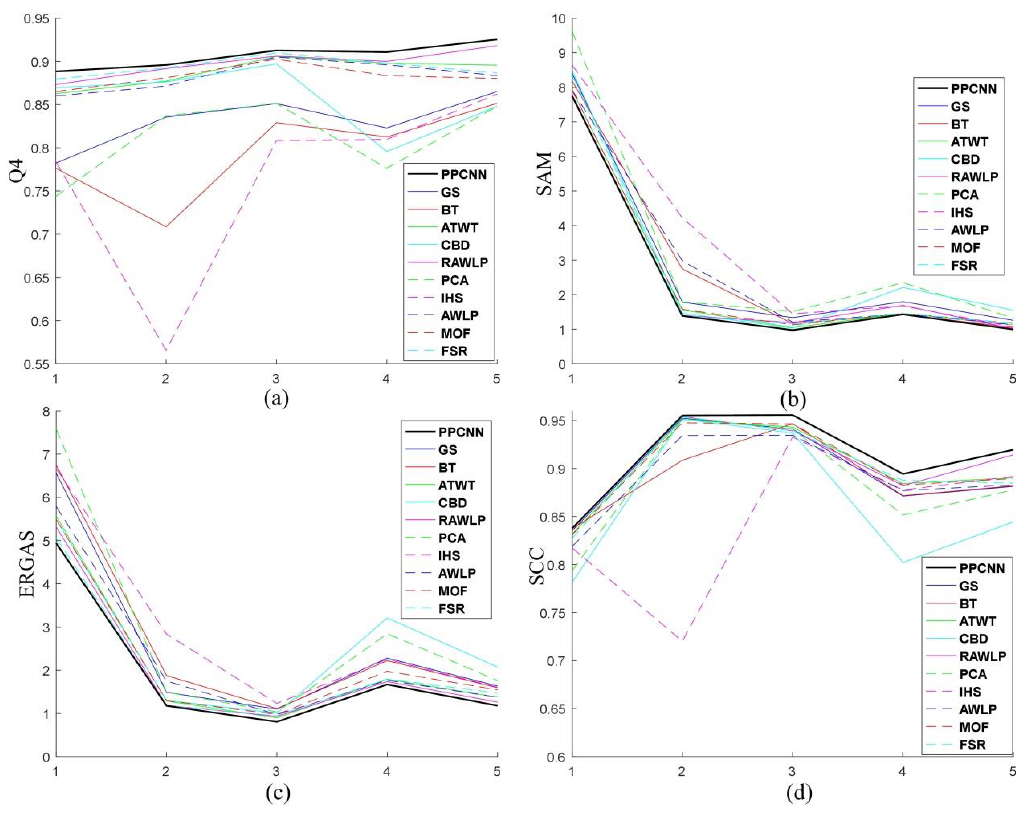
Figure 15. Comparison results of five datasets. ( a ) Q4. ( b ) SAM. ( c ) ERGAS. ( d )